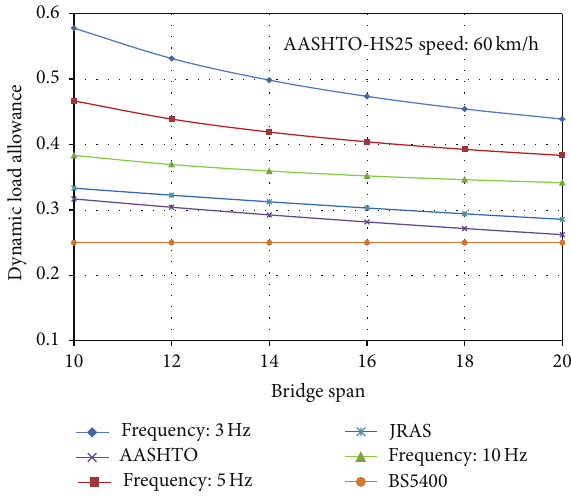
Figure 11: DLA with different bridge frequency and span